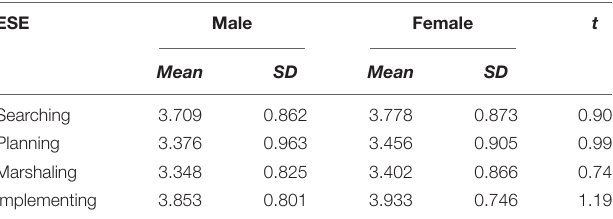
TABLE 3 | T -tests of entrepreneurial self-efficacy in entrepreneurship stages.